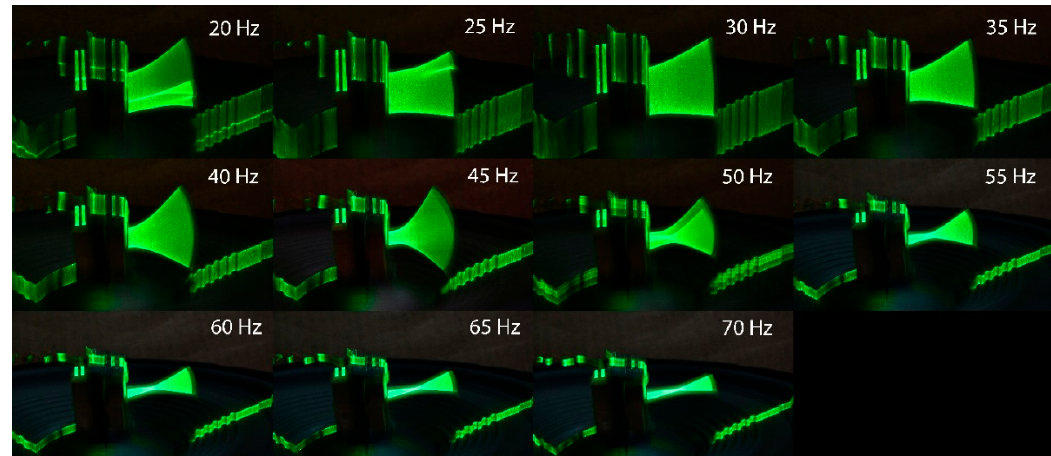
Figure 12. Laser projections of the piezo film with only flow excitation in various fan speeds.